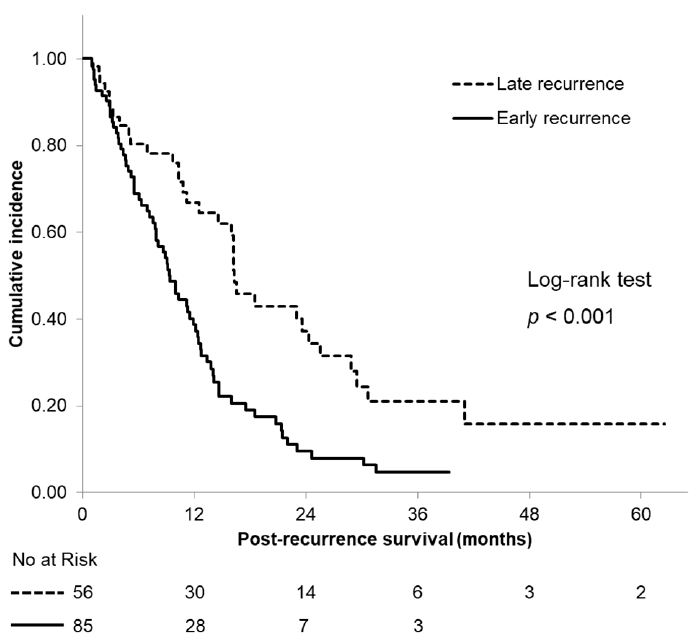
Table 2. Demographic, clinicopathological and treatment characteristics of patients with recur- rence.